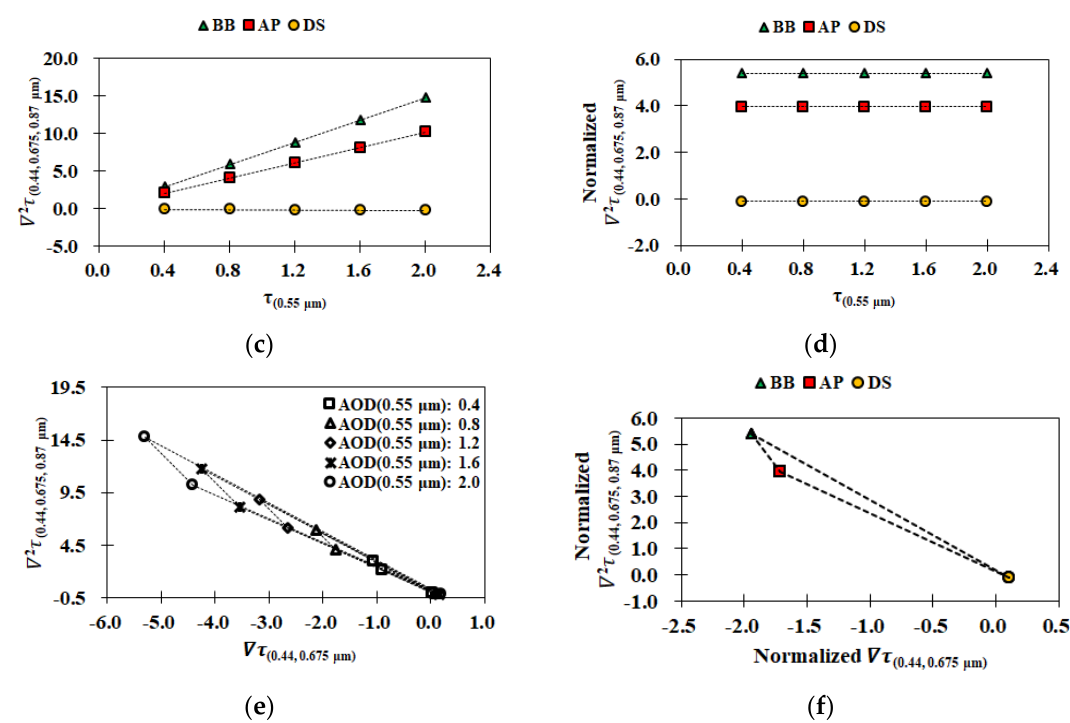
Figure 4. The comparisons of first and second–order derivatives versus aerosol loading ( τ 0.44 µ m ) between values before (panel a , c ) and after (panel b , d ) normalization based on spectral AODs at 0.44, 0.675 and 0.87 µ m. The domain locations of BB (triangle symbol), AP (square symbol) and DS (circle symbol) aerosols in first and second–order derivatives before (panel e ) and after (panel f ) normalization are also demonstrated. The chained lines between symbols represent potentially the dynamic ranges of DS-AP, DS–BB and AP–BB mixtures, respectively. Table 3. The optical properties of AP, BB and DS aerosols from AERONET measurements and 6S simulations from